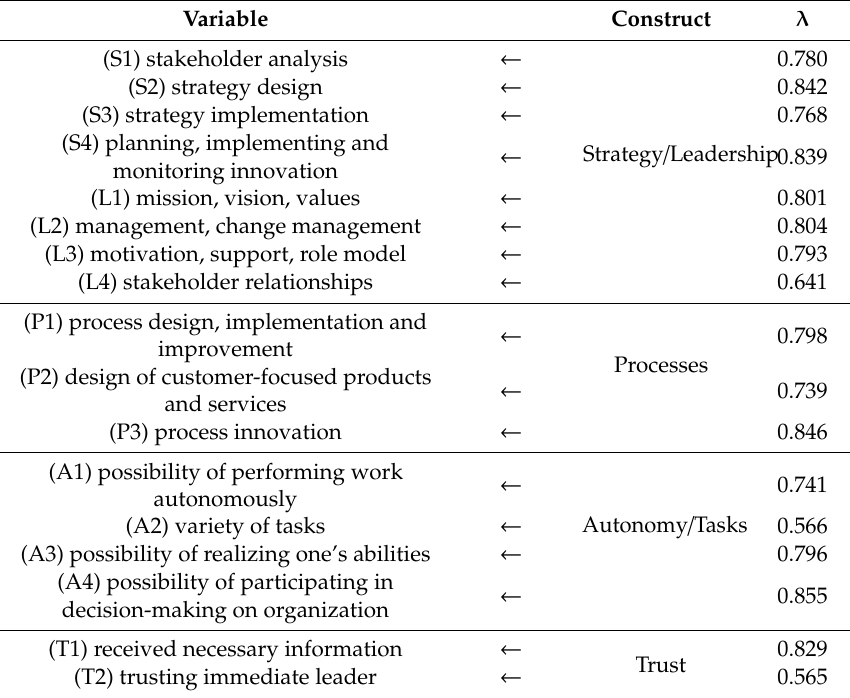
Table 2. Standardized factor